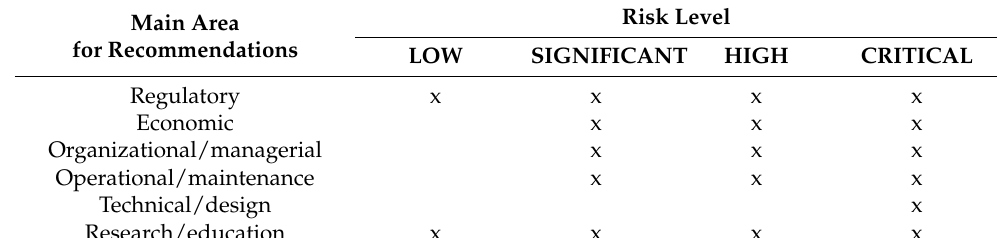
Table 7. Main areas for recommendations based on the obtained risk level.